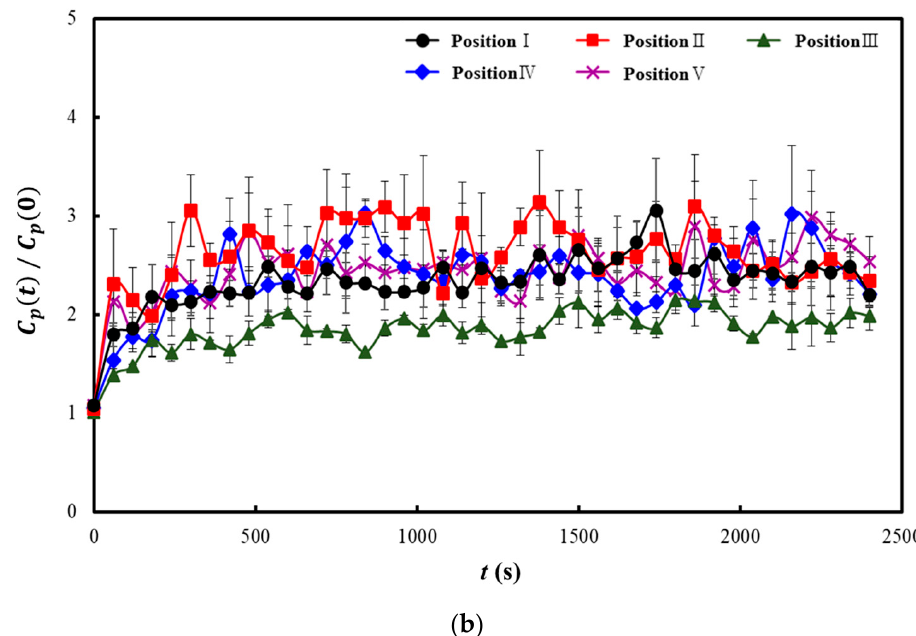
Figure 7. Comparison of the dimensionless particle number concentrations according to the opening of the windows when two air purifiers were operated: ( a ) case 6; ( b ) case 15.